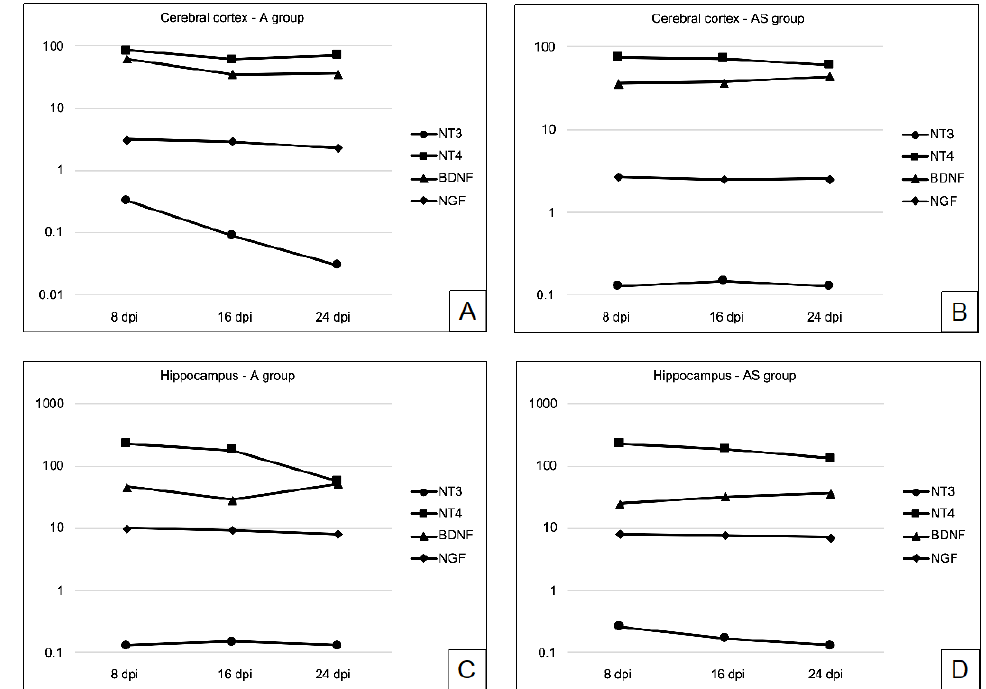
Figure 5. Concentrations of neurotrophin 3 (NT3, ng/mg protein), neurotrophin 4 (NT4, pg/mg protein), brain-derived neurotrophic factor (BDNF, pg/mg protein), and nerve growth factor (NGF, pg/mg protein) in the cerebral cortex of infected immunocompetent (A) and immunosuppressed mice (AS) (pictures ( A ) and ( B ), respectively) and in the hippocampus of infected immunocomptent (A) and immunosuppressed mice (AS) (pictures ( C) and ( D ), respectively).